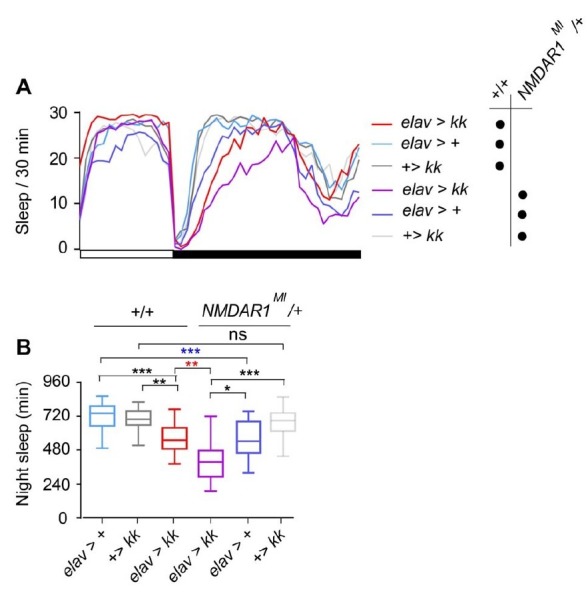
Nca and NMDAR1 mutations additively affect sleep.(A) Mean sleep patterns of NcaKD males (elav > kk) and heterozygous controls with and without one copy of the NMDAR1MI11796 (NMDAR1MI/+) allele in 8L: 16D conditions. (B) Median night sleep levels in the above genotypes. Heterozygosity for NMDAR1MI11796 resulted in sleep loss in the background of elav-Gal4/+ controls, and reduced sleep further in an additive manner in elav > kk males. elav > kk; NMDAR1MI/+: n = 32; elav > +; NMDAR1MI/+: n = 26; + > kk; NMDAR1MI/+n = 38; elav > kk: n = 32; elav > +: n = 30; + > kk: n = 34. ns – p > 0.05, *p < 0.05, **p < 0.01, ***p <0.001, Kruskal-Wallis test with Dunn’s post-hoc test.